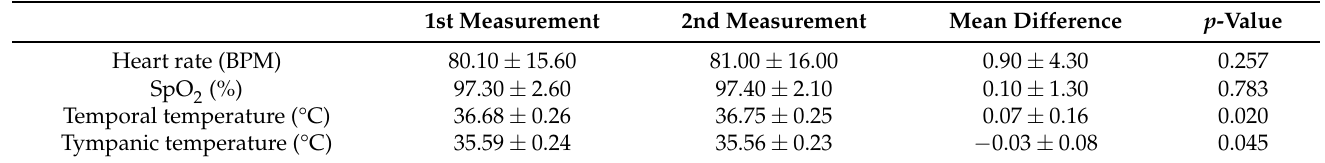
Table 2. Pairwise comparison of the e-CoVig repeated measurements.